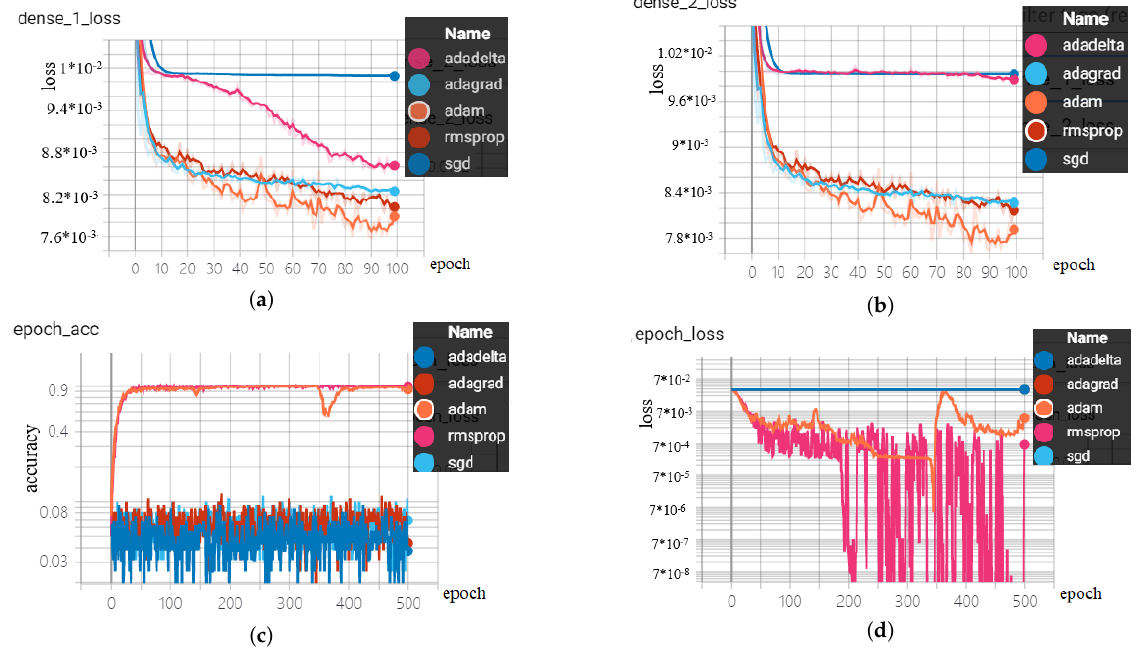
Figure 10. LSTM with autoencoder test results for time series forecasting task ( a ): encoder’s loss, ( b ): decoder’s loss, LSTM with Attention test ( c ): accuracy, ( d ): loss. Table 1. Test results of web traffic forecasting with different optimizers ‘training/test losses (time)’.